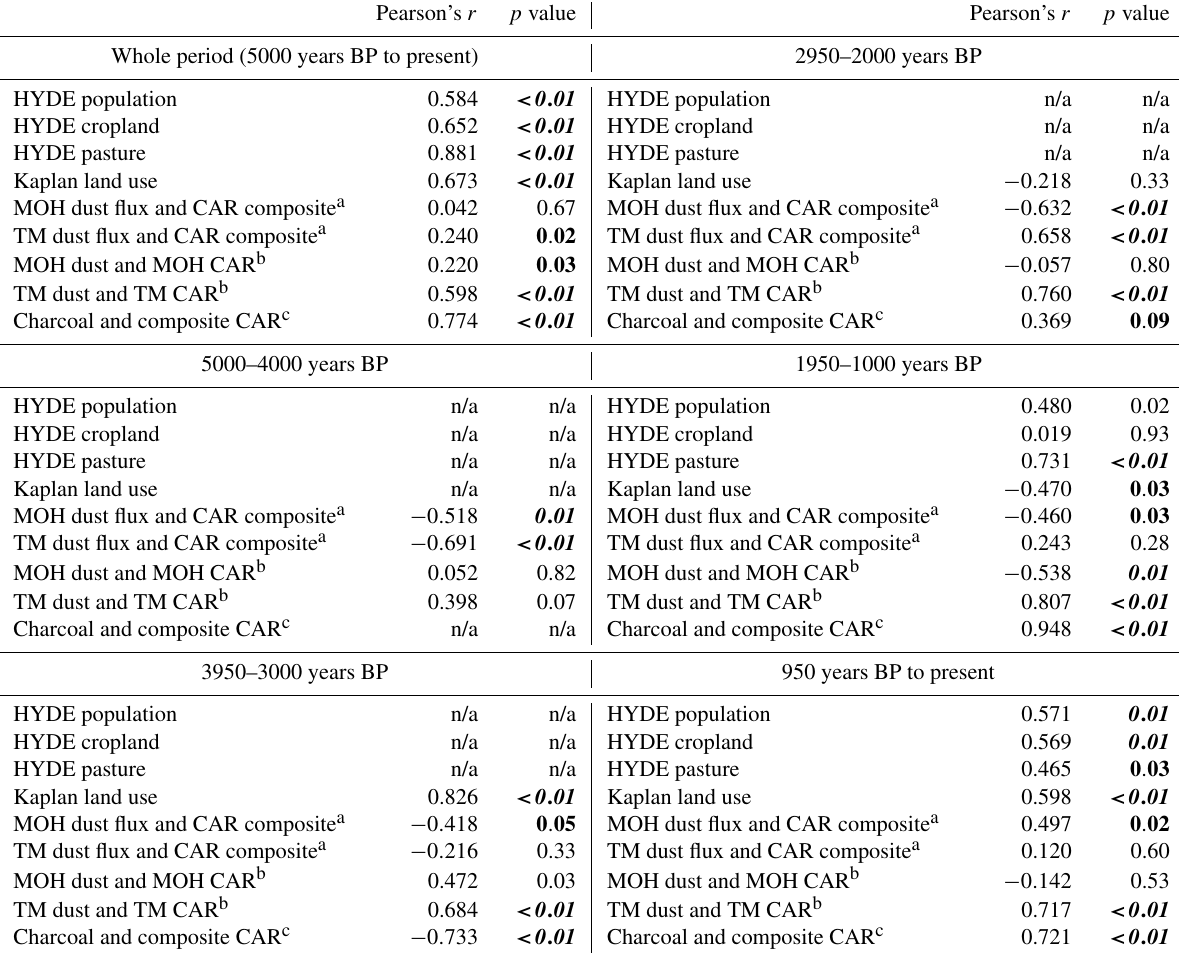
Table 4. Correlation coefficients and p values between the indicators of human impact and between dust input and the reconstructed carbon accumulation rates, for a selection of time periods. The p values significant at the 0.05 level are highlighted in bold, whereas those significant at the 0.01 level are